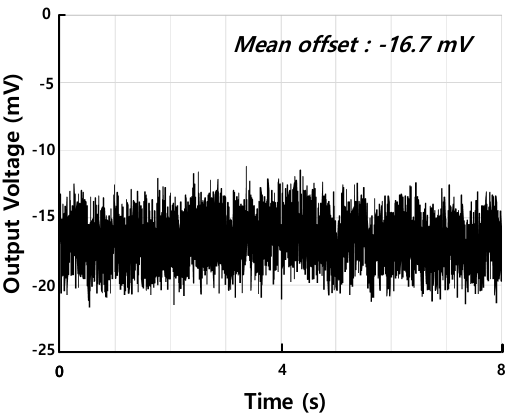
Figure 14. ( a ) Linearity expressed as the ratio of the digital output code to the input capacitance. ( b ) Capacitance noise floor.